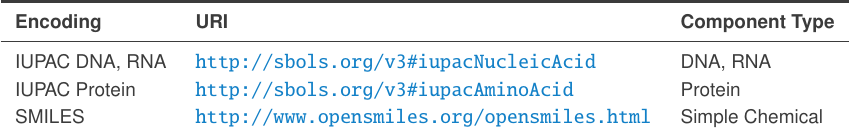
Table 1: URI s for specifying the encoding property of a Sequence , organized by the type of Component (see Table 2) that typically refer to a Sequence with such an encoding .